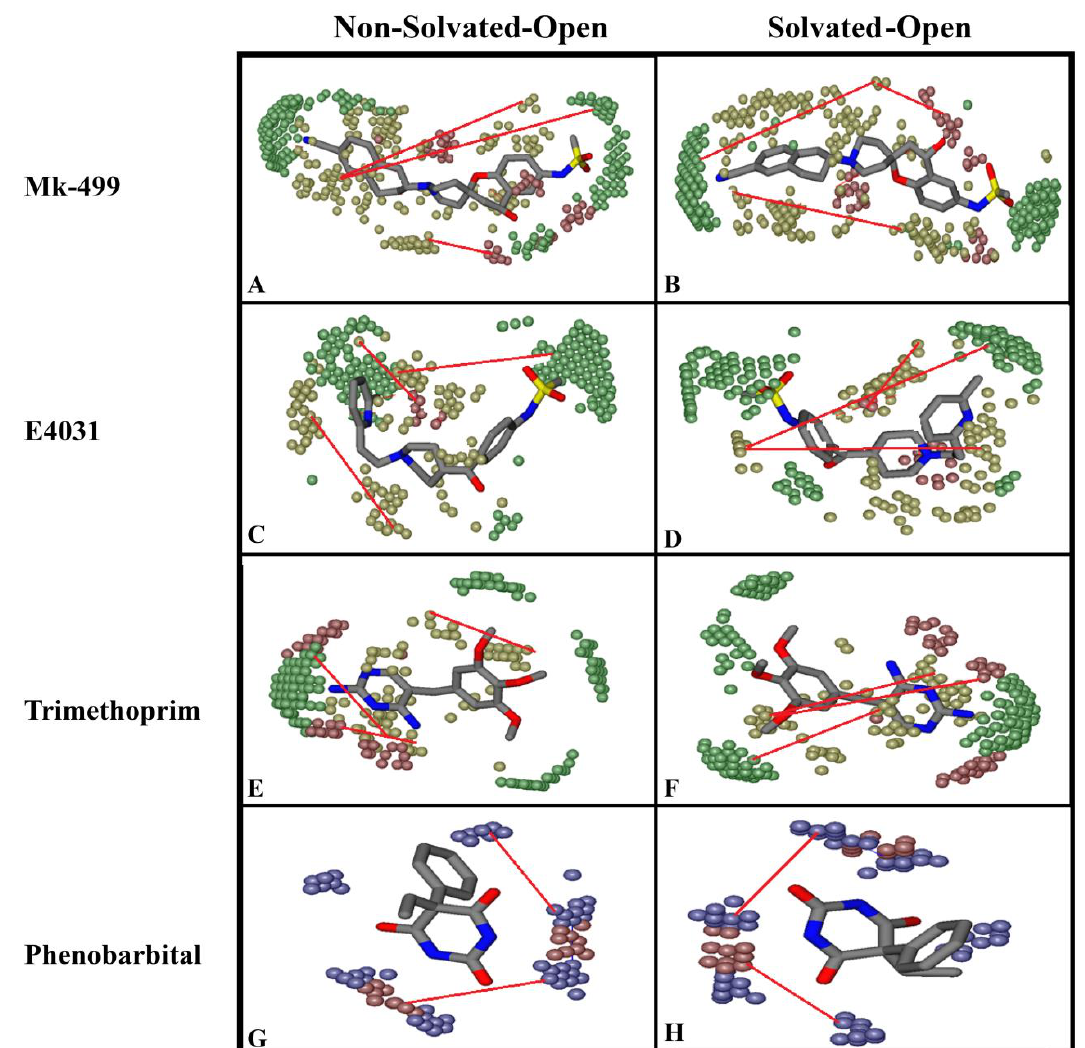
Figure 11. Comparison of Important hotspots regions of non-solvated-open and solvated-open model. Red lines represent the respective distance between the two features that enlist in Table 2. DRY-DRY (yellow hotspots) shows the distance between two hydrophobic features. DRY-TIP yellow and green hotspots respectively shown the distance between hydrophobic feature and steric molecular boundary, DRY-O yellow and red hotspots shows the distance between the hydrophobic group and hydrogen bond donor group that positively contribute the hERG inhibitory potency and the features obtained from solvated and non-solvated conformations are almost similar. ( A ) MK-499 MIF of non-solvated-open state and their respective distances. ( B ) MK-499 MIF of solvated-open state and their respective distances. ( C ) E4031 MIF of non-solvated-open state and their respective distances. ( D ) E4031 MIF of solvated open state and their respective distances. ( E ) Trimethoprim MIF of non-solvated open state and their respective distances. ( F ) Trimethoprim MIF of solvated open state and their respective distances. Likewise ( G ) phenobarbital in non-solvated-open state and their respective distances. ( H ) Phenobarbital in solvated-open state and their respective distances show N1-N1 blue hotspots showing two hydrogen bond acceptor feature and O-NI red and blue hotspot respectively represent present at a particular distance impact negatively towards biological potency of hERG